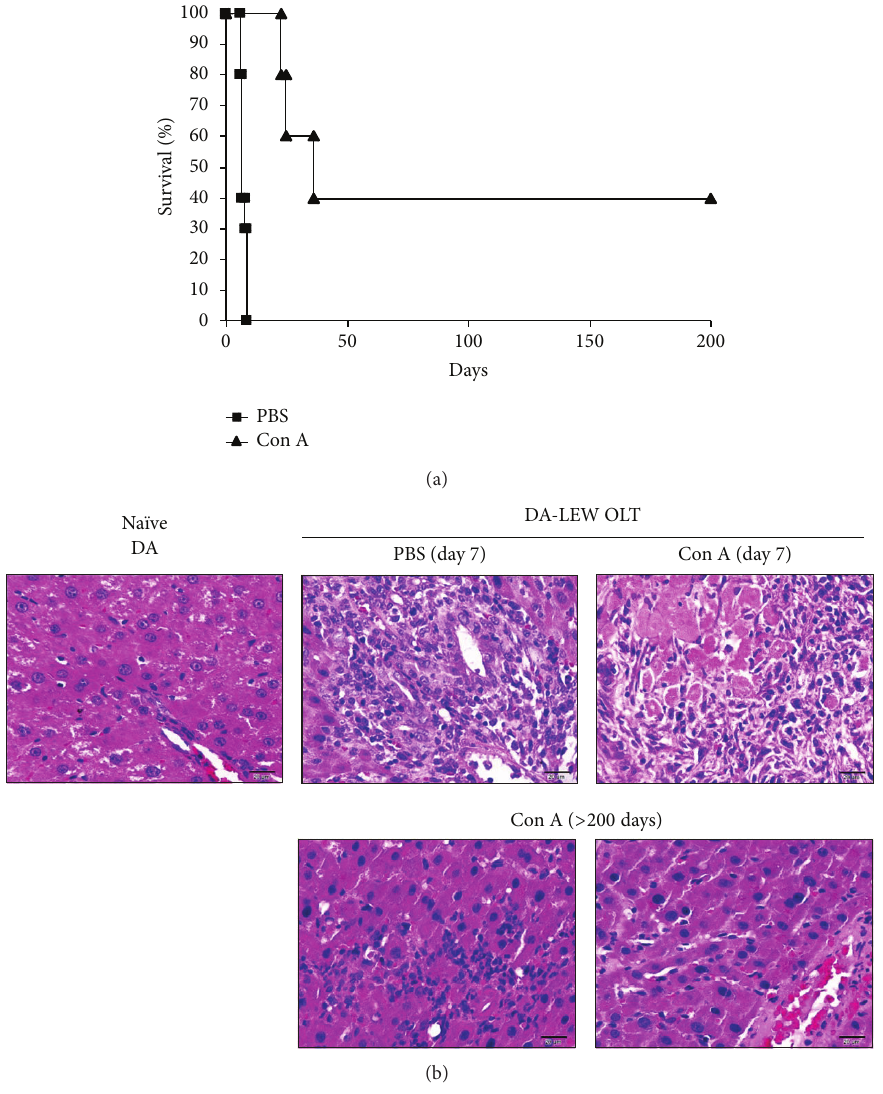
Figure 1: The prolongation of allograft survival by the transient induction of de novo autoimmune hepatitis. (a) The DA liver allograft survival of DA-LEW OLT with Con A injection ( 𝑛 = 5 ) was significantly prolonged ( 𝑃 = 0.001 , log-rank test) compared with the survival in the control PBS group ( 𝑛 = 10 ). (b) Paraffin sections of na¨ıve and OLT livers at rejection (day 7) or acceptance ( > 200 days) were stained with hematoxylin and eosin. The data are representative examples of three (na¨ıve and OLT at day 7) or two ( > 200 days) individual liver sections (40x magnification, bar = 20 𝜇